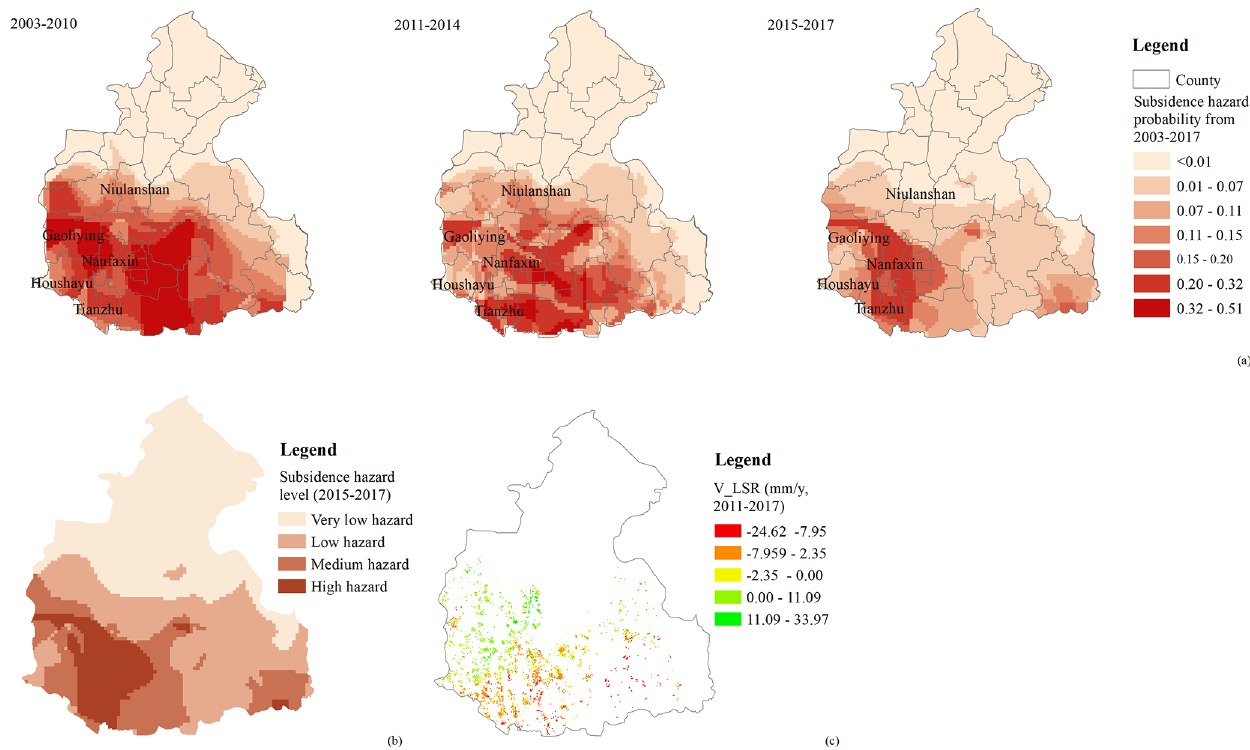
Figure 6. (a) Assessment of the subsidence hazard probability from 2003 to 2010, 2011 to 2014, and 2015 to 2017; (b) subsidence hazard level (2015–2017); (c) variation of the land subsidence rate (V_LSR) between 2010–2014 and 2015–2017 as obtained by PS-InSAR.